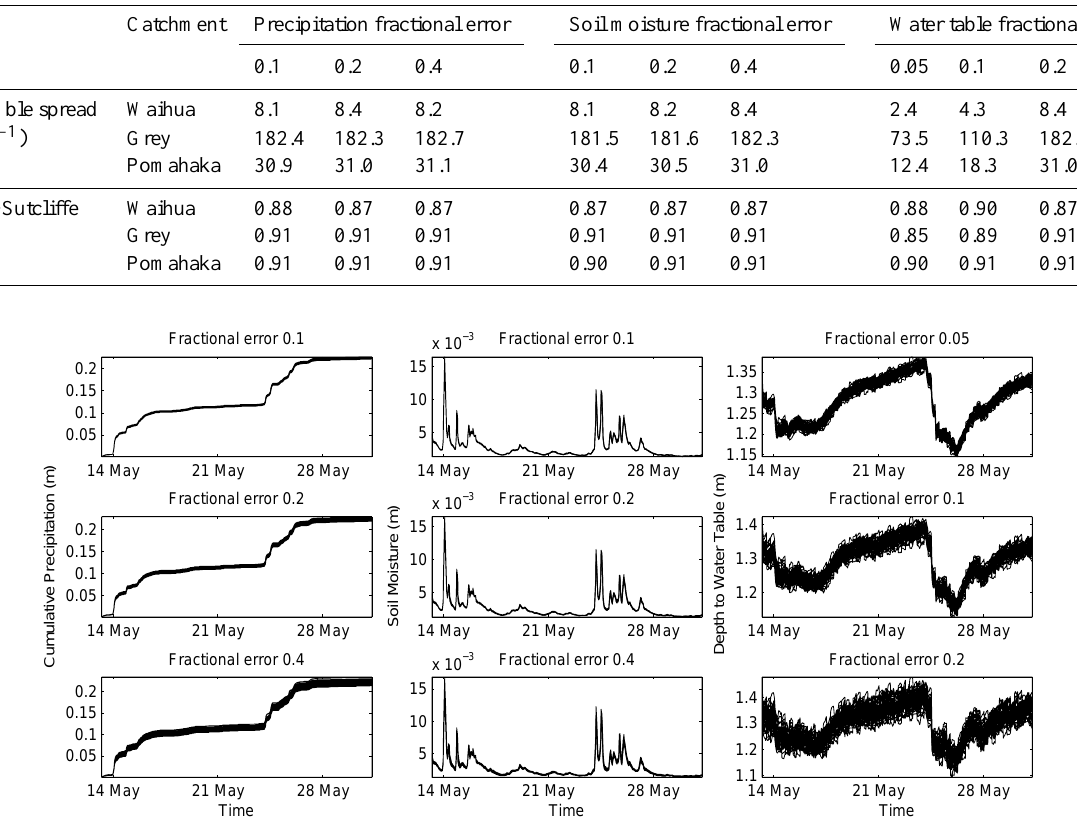
Fig. 10. Ensemble spread during an example REnKF model run for (left panels) cumulative precipitation, (middle panels) soil moisture and (right panels) depth to water table, with increasing fractional error parameter. Series shown for the Grey catchment, average values over all